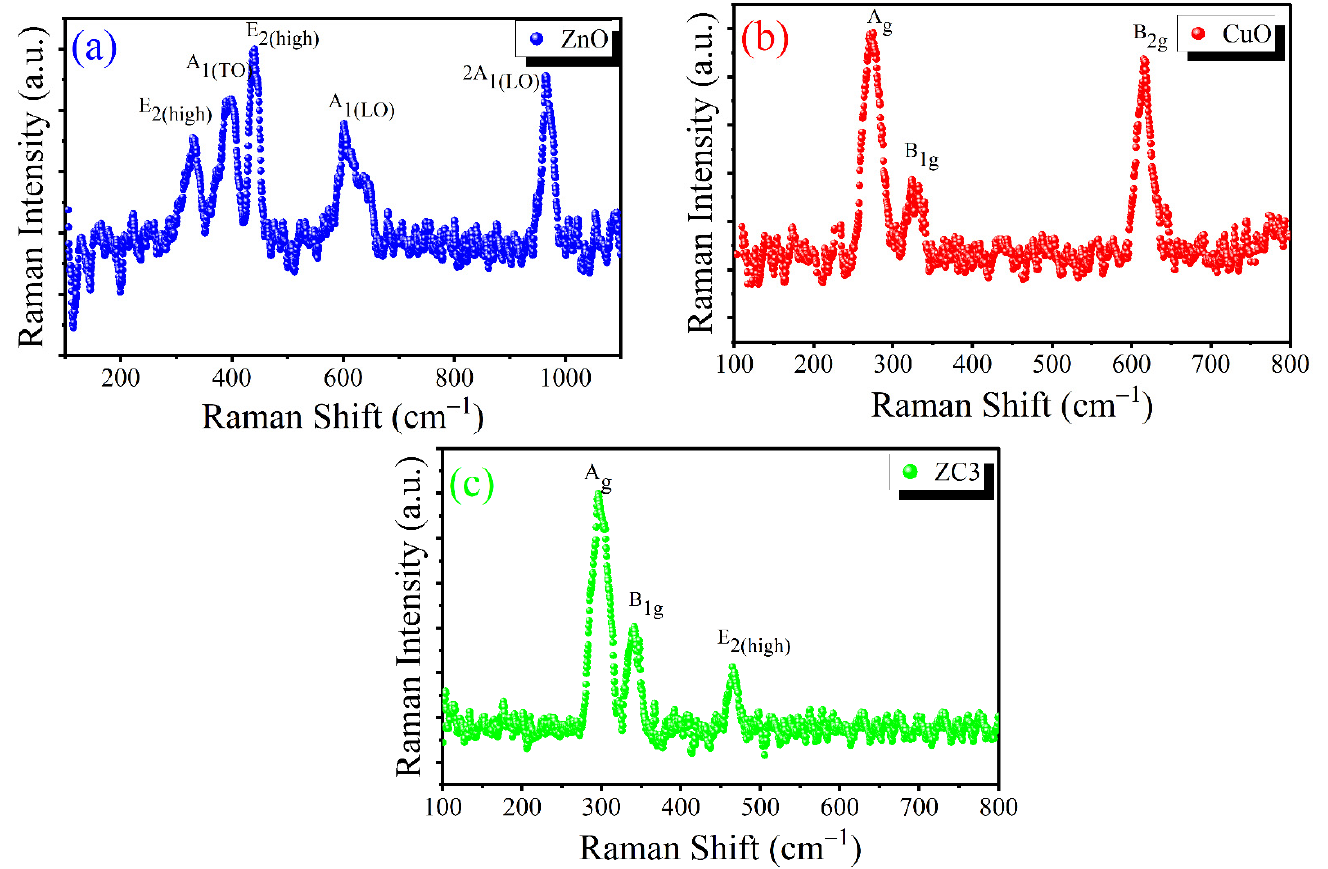
Figure 4. Raman spectra for ( a ) ZnO, ( b ) CuO, and ( c ) ZC3